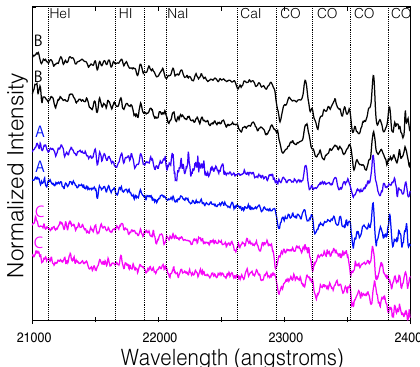
Figure 5: Examples of K s -band spectra in the CBF. Upper label of each spectrum shows groups in § 2.1.3 defined by X-ray